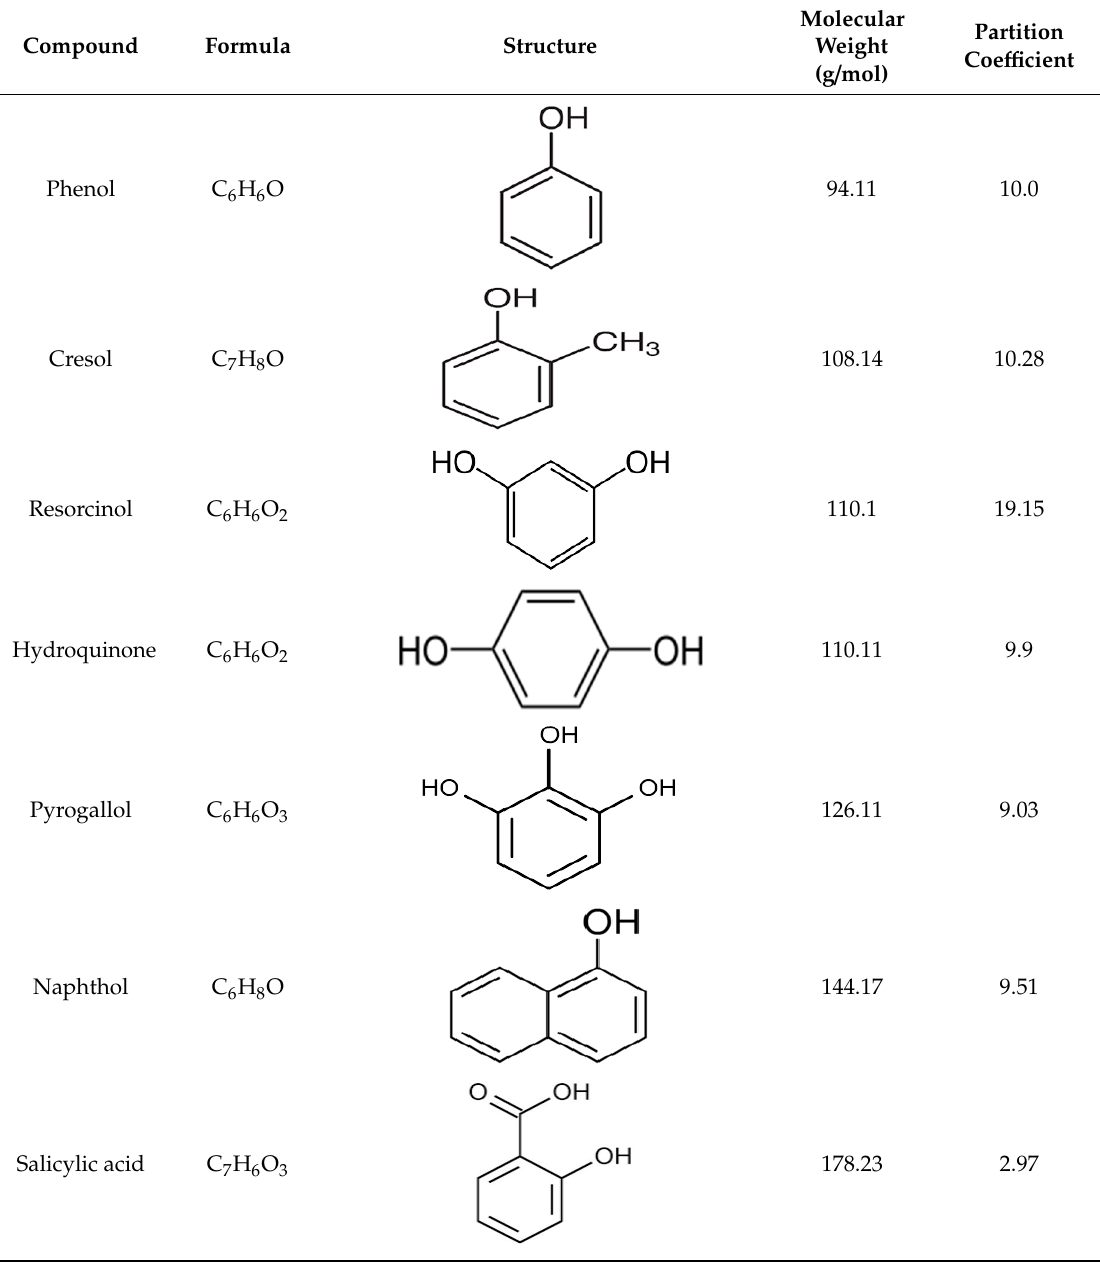
Table 2. Chemical structures and log p values of polycyclic aromatic hydrocarbons studied. Compound Formula Structure